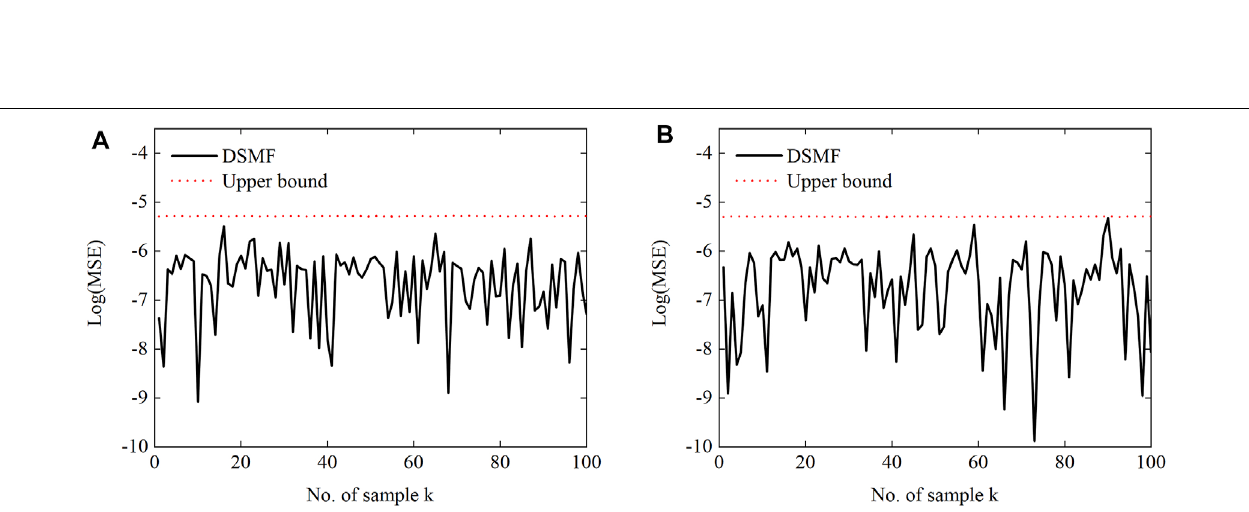
FIGURE 9 | Log(MSE) between the true and estimated values of a-phase at bus 4 for the ET-DSMF algorithm: (A) the real part of the voltage and (B) the imaginary part of the voltage.